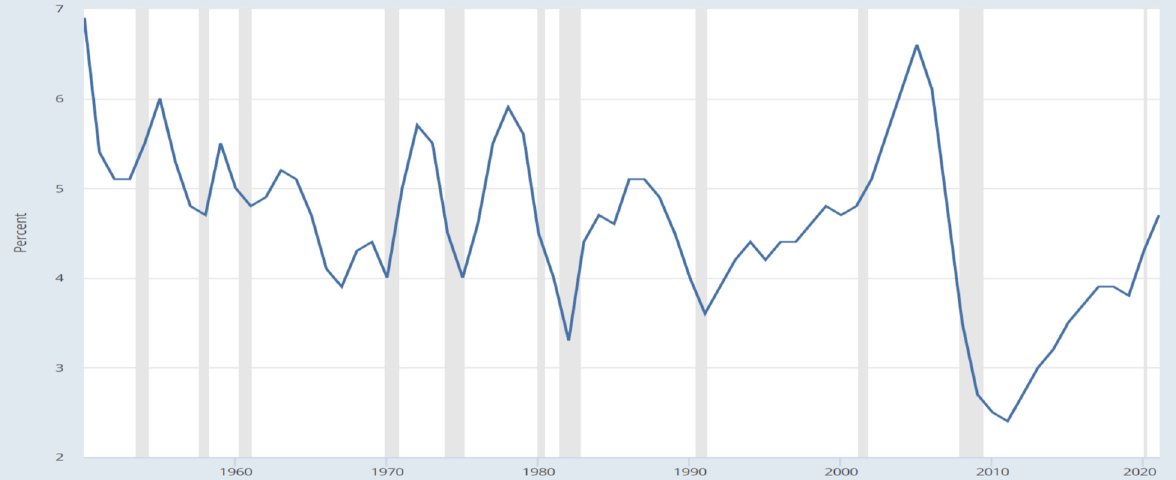
Figure 16. Residential Investment as a Percent of GDP. Source: US Bureau of Economic Analysis.